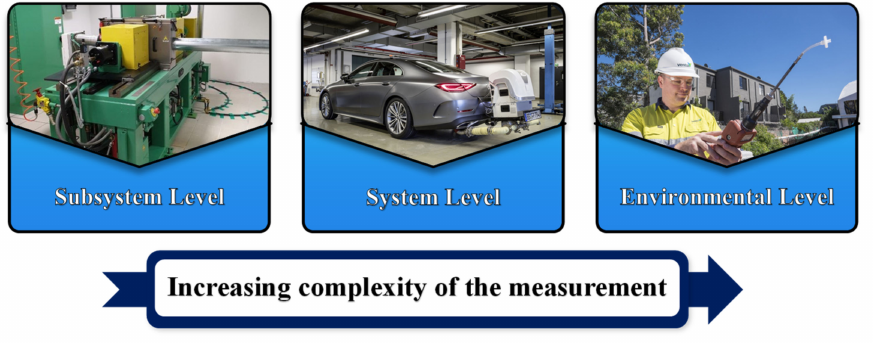
Figure 1. Hierarchical levels of